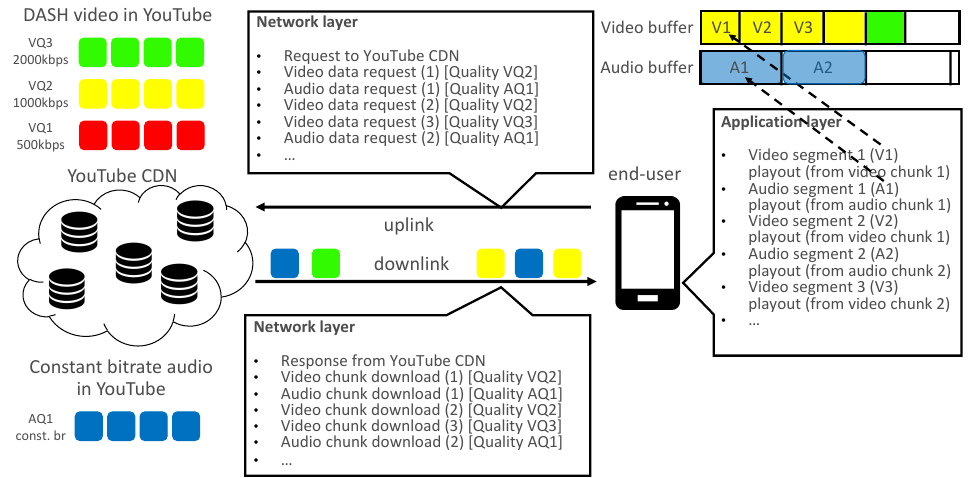
Figure A1. YouTube streaming behavior at network and application